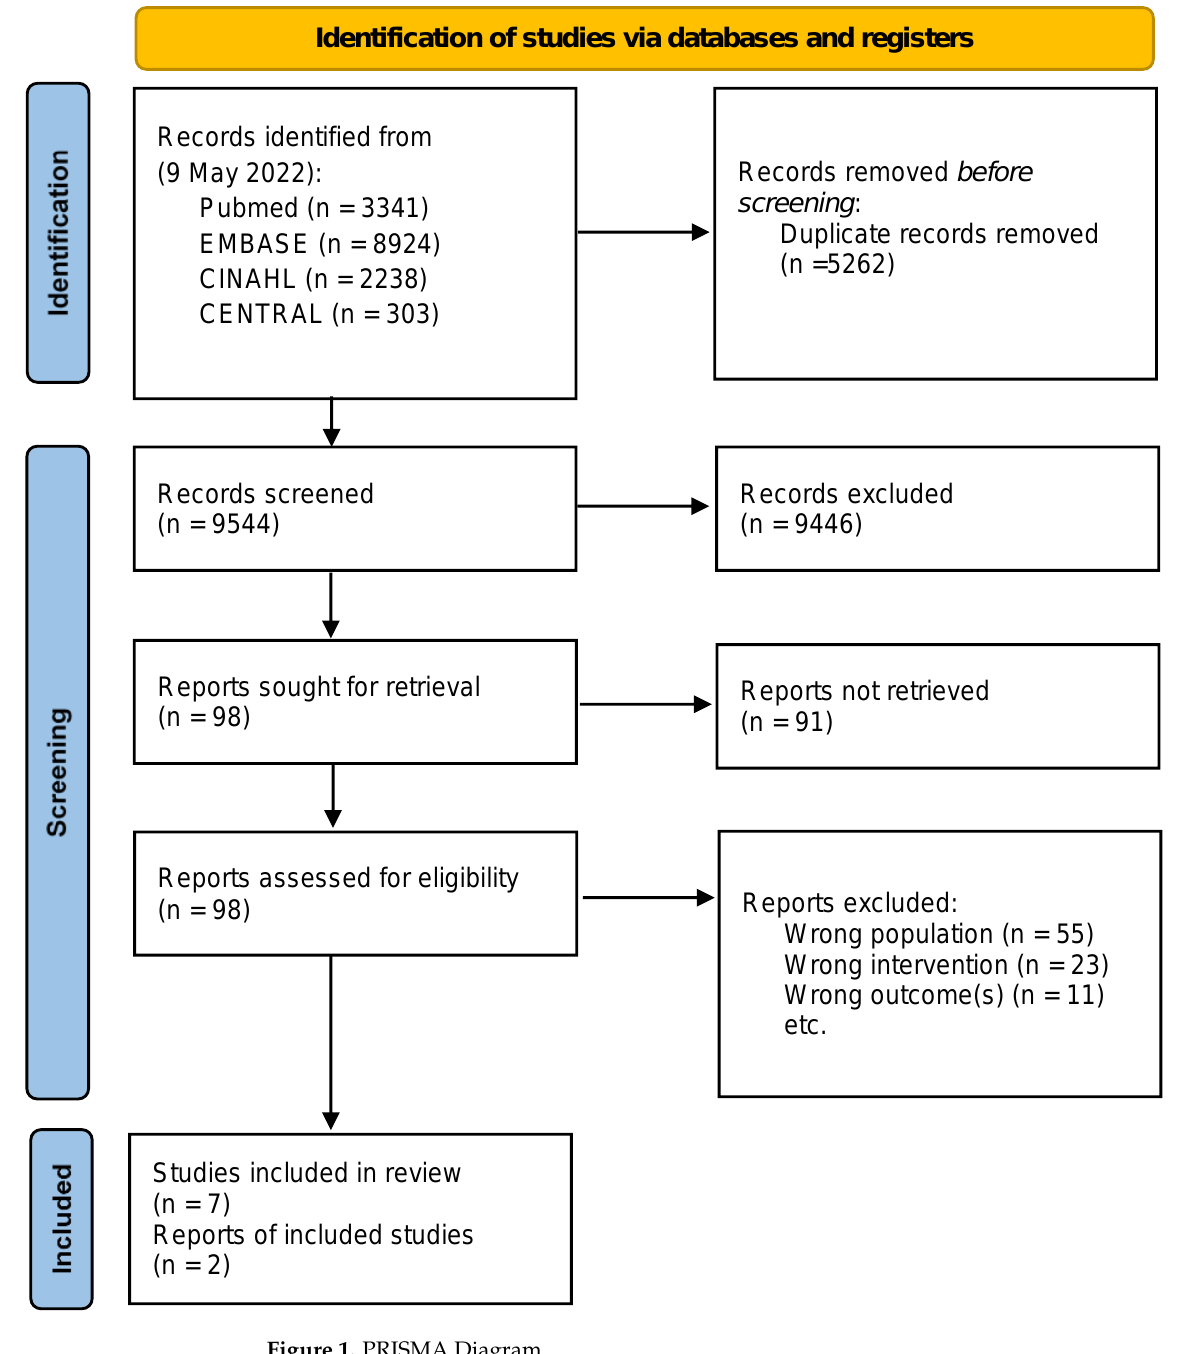
Figure 1. PRISMA Figure 1. PRISMA Diagram .